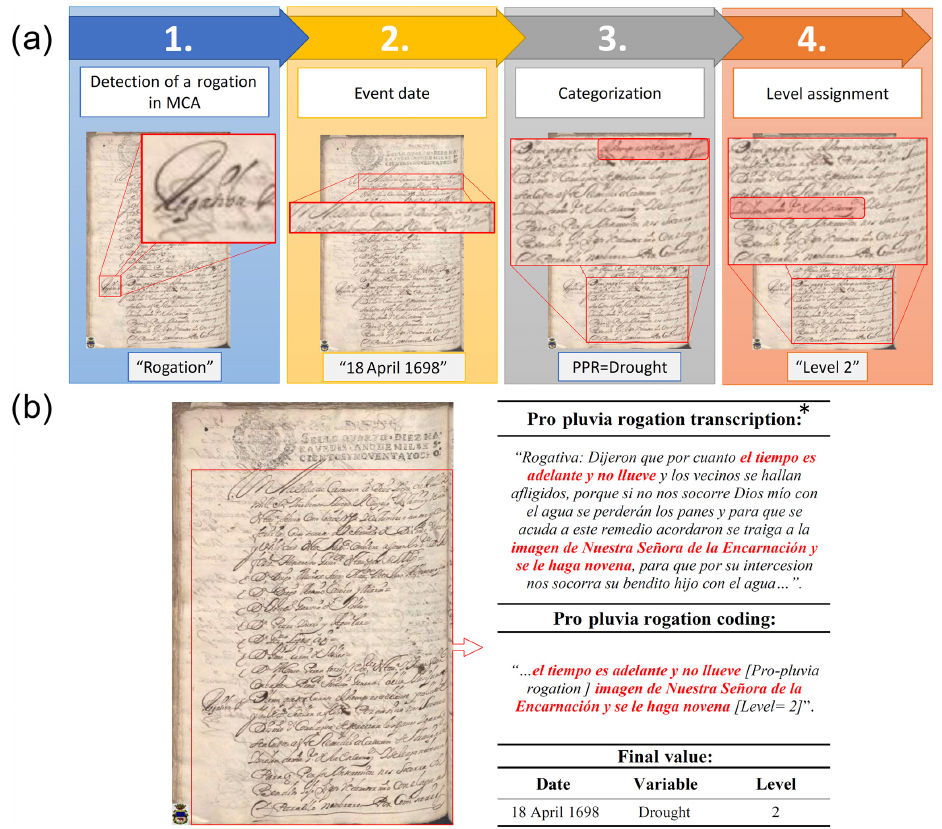
Figure 3. RO method by step (a) and encoding example of the RO method (b) . This particular example refers to a pro pluvia RO on 18 April 1698, so the reconstructed variable is drought. Source: the Carmesi Project. This text is written in Old Spanish. An approximate translation is the following: “They said that the season is very advanced and it has not rained and the population is afflicted, and unless God helps us with rain the crops will be lost. Therefore, they agreed to bring the image of “Our Lady of Encarnación” and to celebrate nine masses praying so that She asks to her Son to help us with